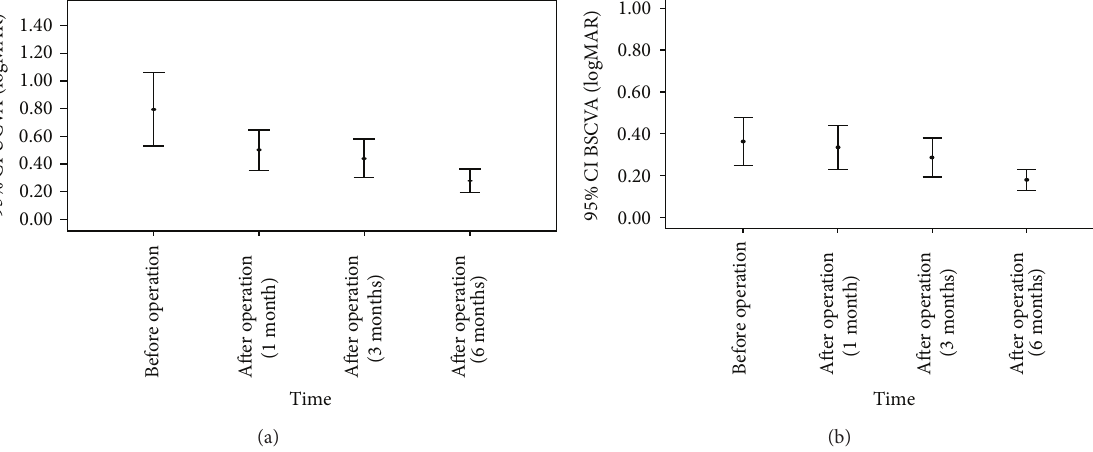
Figure 2: Mean change in visual acuity. Mean uncorrected visual acuity (a) and best spectacle-corrected visual acuity (b) after Keraring 355 ∘ implantation during the follow-up period.